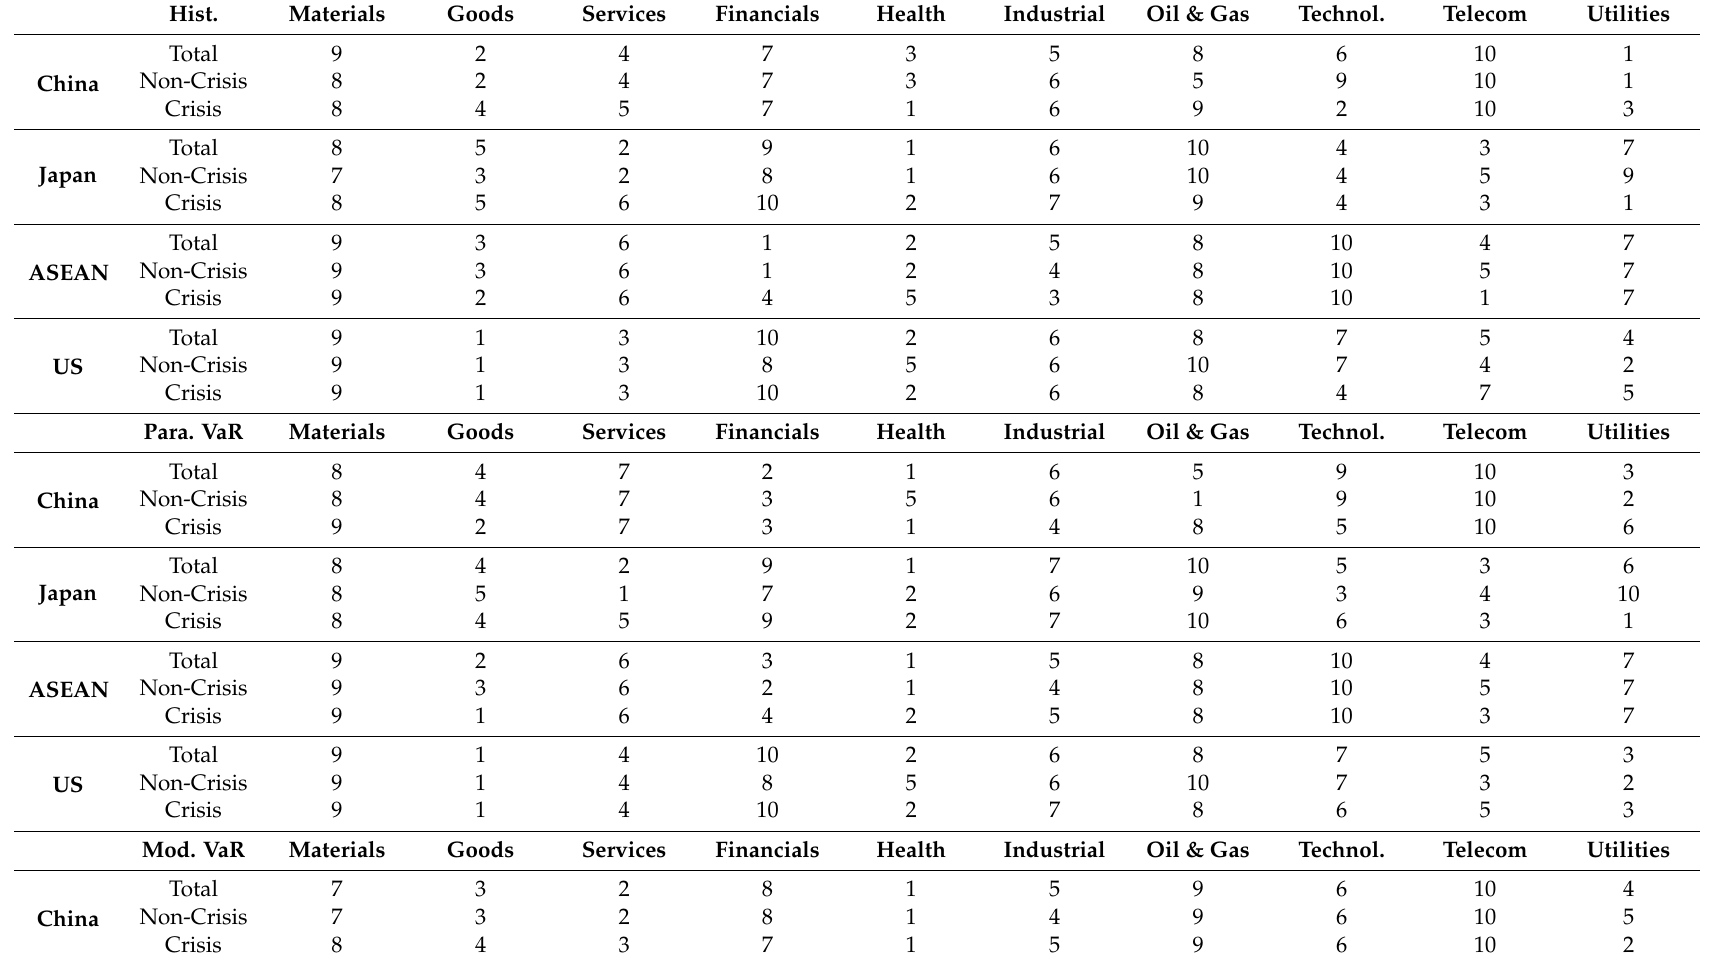
Table A4. 99% VaR and CVaR rankings per industry: